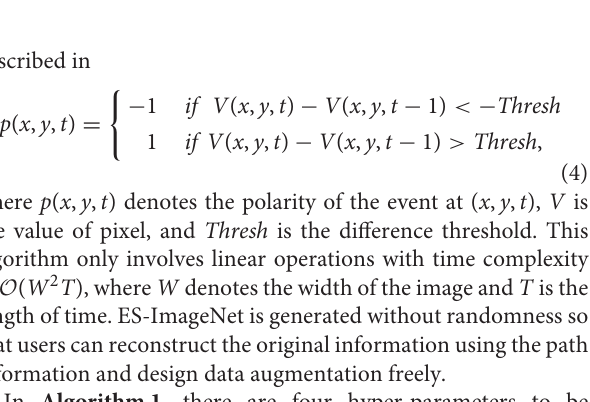
FIGURE 2 | The moving trajectory of images used to generate the events. The numbers in the small blue squares is the timestamp when an image reaches the corresponding position. The pipeline shows the complete process of generating an event stream.